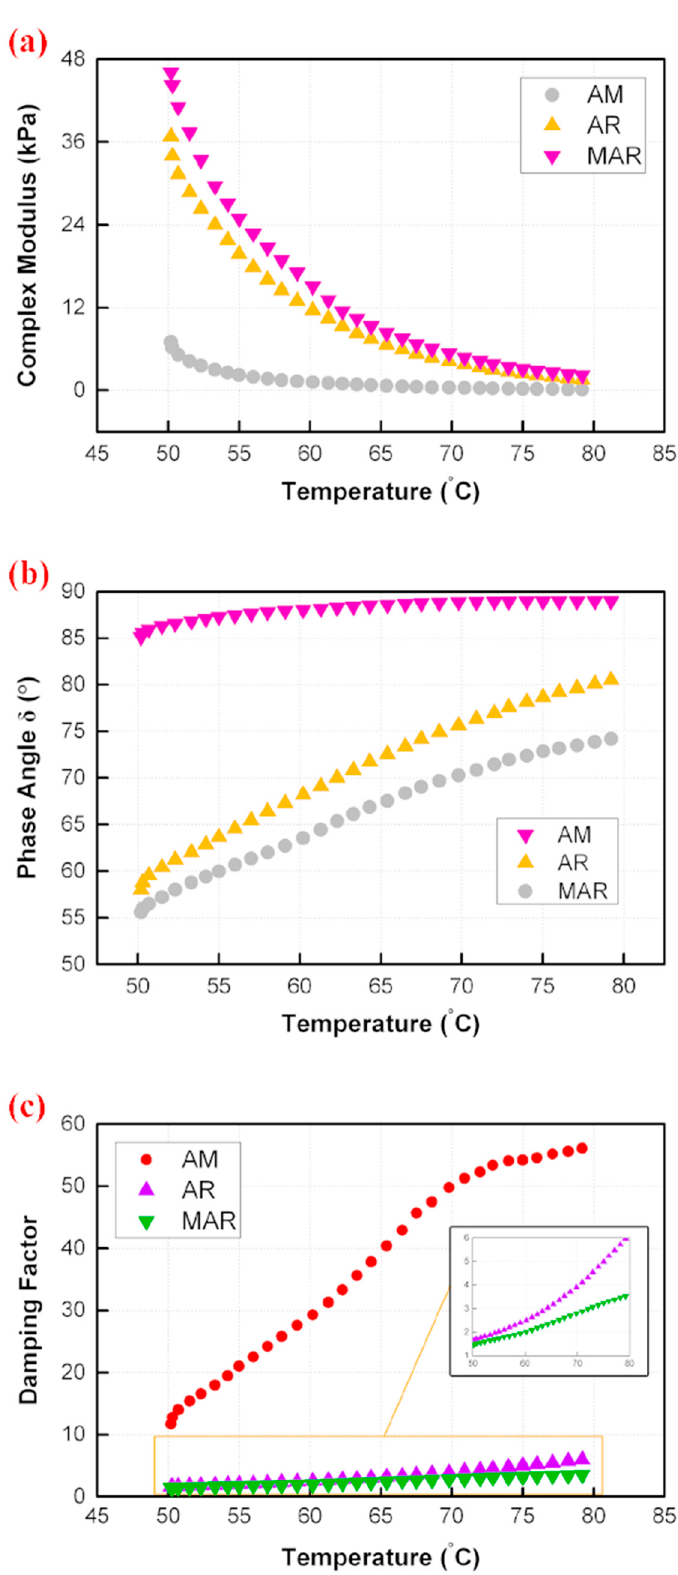
Figure 1. DSR temperature scanning test results, where ( a ) shows complex modulus, and ( b ) shows phase angle, and ( c ) shows damping factor.